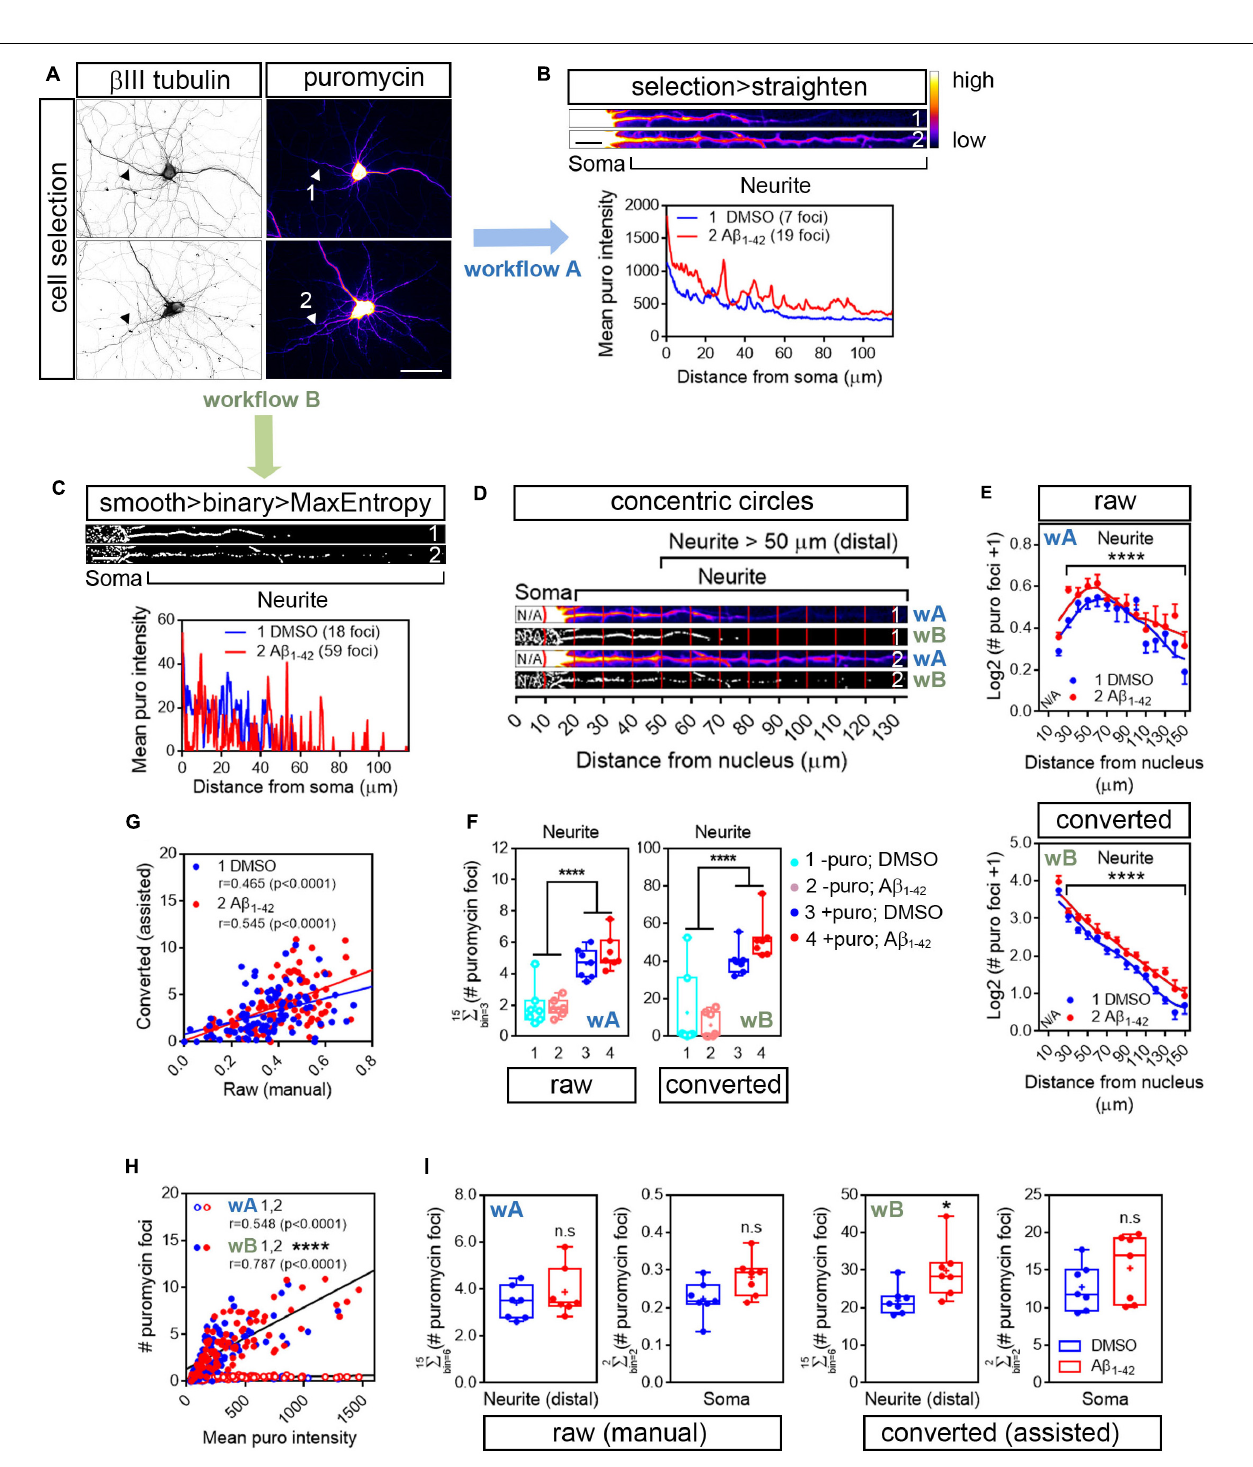
FIGURE 3 | Image processing reveals an effect of A β 1-42 oligomers on neuritic translation sites. (A) Rat hippocampal neurons were grown for 9 DIV and were treated with DMSO or A β 1 - 42 oligomers for 24 h. Cells were incubated with puromycin for 30 mins and processed for β III tubulin (gray) and puromycin immunostaining (heatmaps). Scale bar, 50 µ m. (B) Following workflow A, the longest puromycin- and β III-positive neurite in raw images was selected with a segmented line and straighten. Puromycin-positive discrete puncta were analyzed by visual inspection as exemplified in the intensity profiles obtained from straighten neurites (heatmaps). 1 and 2: 30 min puromycin incubation in DMSO- and A β -treated cells, respectively. Scale bar, 10 µ m. (C) Following workflow B, selected neurites were straighten, smoothen and binarized with the MaxEntropy mask (smooth > binary > MaxEntropy). Puromycin-positive discrete puncta were